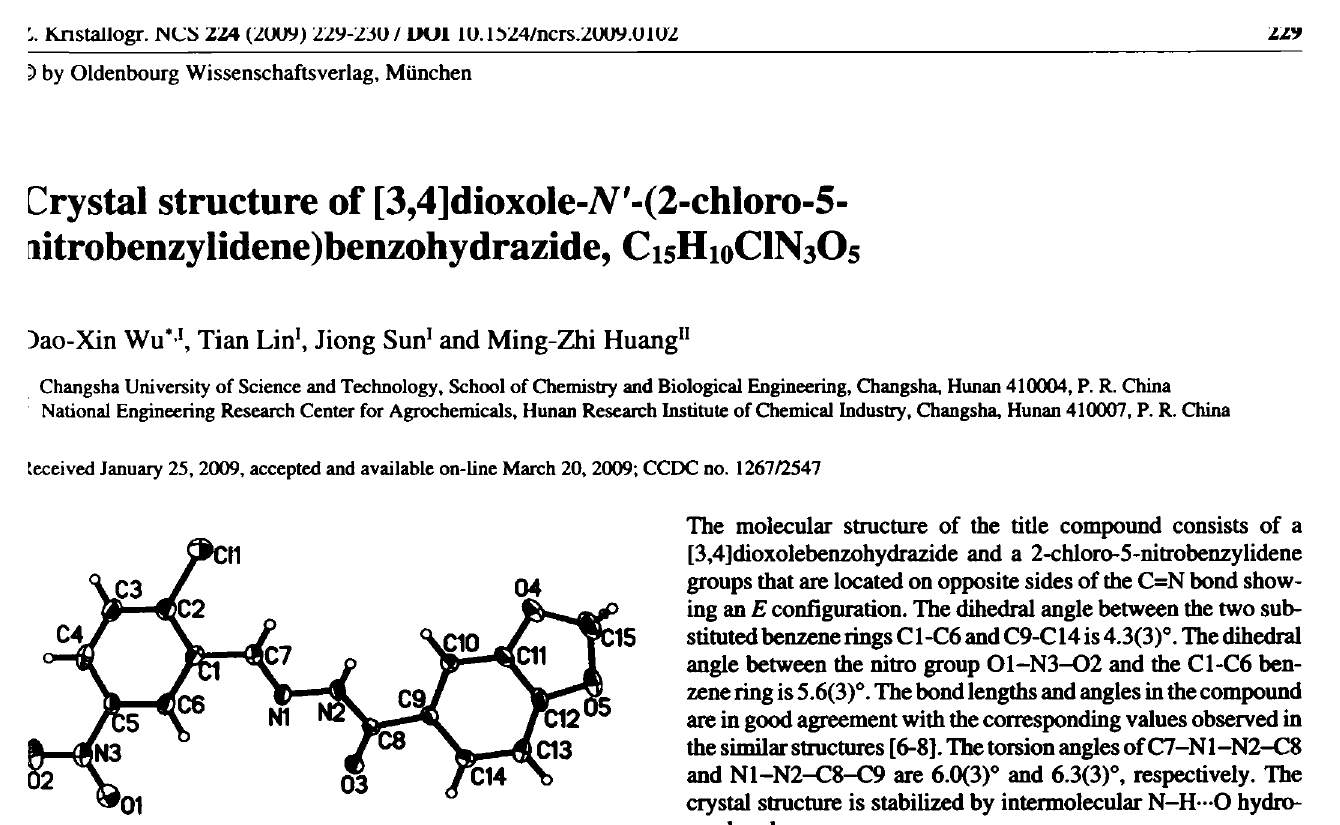
Table 1. Data collection and handling. Crystal: